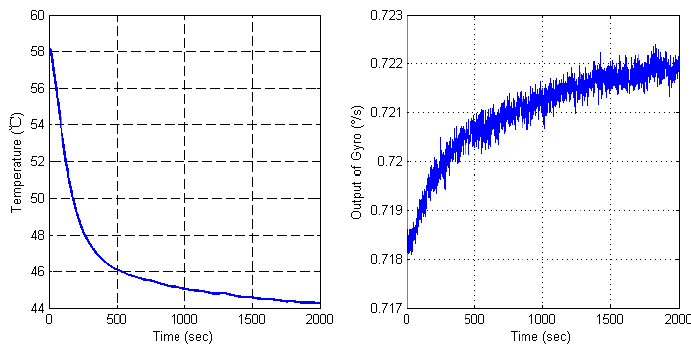
Figure 10. Temperature experimental results of a dual-mass MEMS gyroscope.